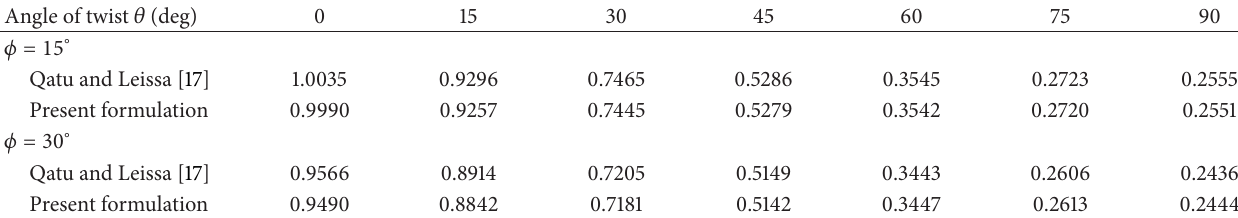
Table 1: Nondimensional natural frequencies (𝜛) for a three-layer graphite epoxy twisted plate.